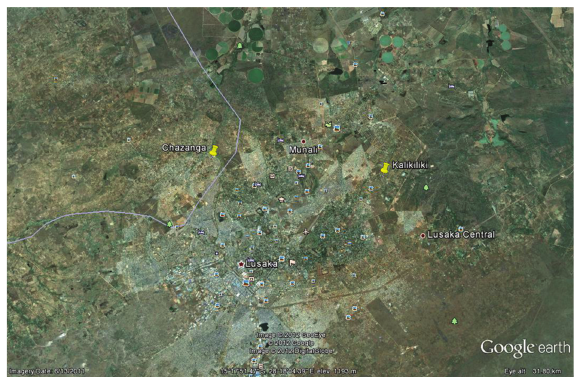
Figure 1: Map of greater Lusaka showing the periurban study site